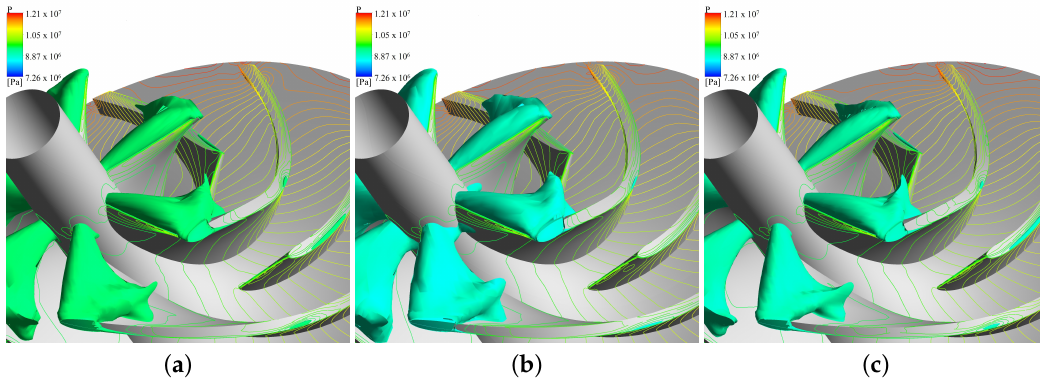
Figure 14. Volume near leading edge shows the regions where the pressure is lower than the inlet pressure at mass flow rate of 3.2 kg/s. ( a ) Impeller alone. ( b ) With vaneless diffuser. ( c ) With vaned